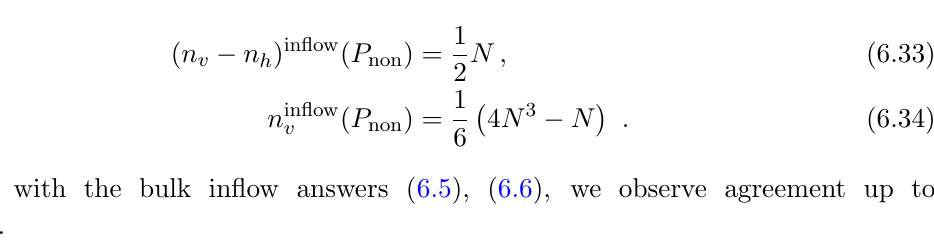
Figure 5 . The Young diagrams corresponding to the four discussed examples, drawn with N = 4 boxes. From left to right, the preserved (cid:13)avor symmetry is: , SU(4), U(1), SU(2). ; This has the net e(cid:11)ect of shifting (cid:31) (cid:31) + 1, or in other words, the number of punctures n ! from n n 1. This is exactly the behavior of a non-puncture, whose only contribution ! (cid:0) is \(cid:12)lling" a hole on the Riemann